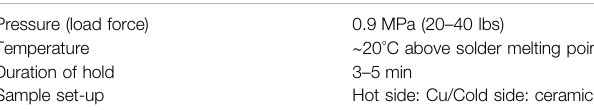
TABLE 2 | Optimized parameters for VACNT based MNC fabrication